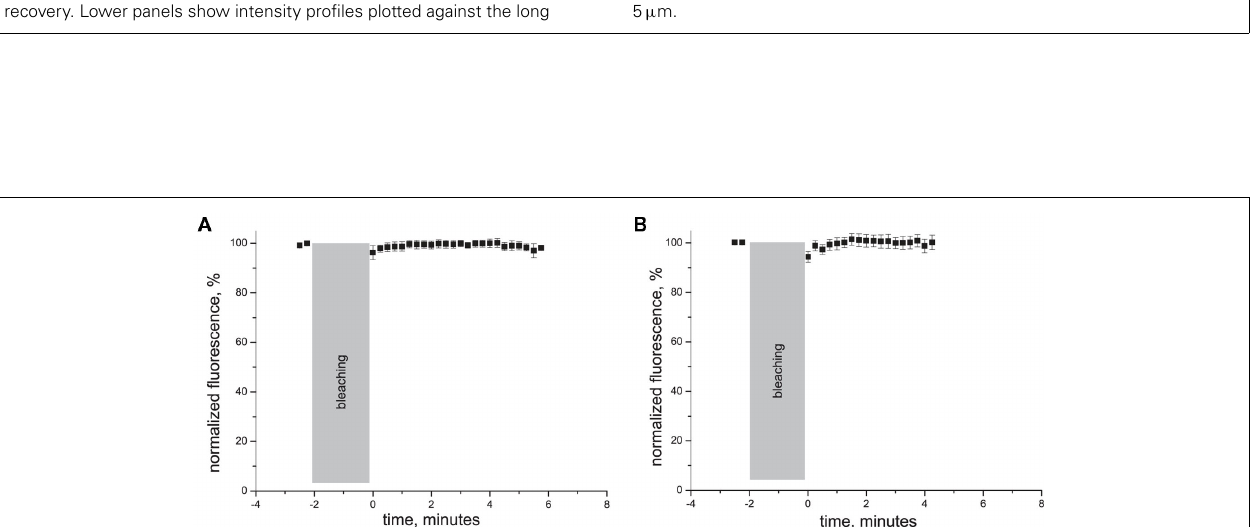
axis of the rectangular regions outlined in yellow.The plotted data were normalized to maximal intensity level. (B) Fluorescence recovery after photobleaching at 21˚C. Note similar spatial patterns at 21 and 29˚C, indicating that lateral diffusion of P2X3-DsRed plays a minimal (if any) role in fluorescence recovery (cf. Pochynyuk et al., 2007). Scale bars: 5 μ m.